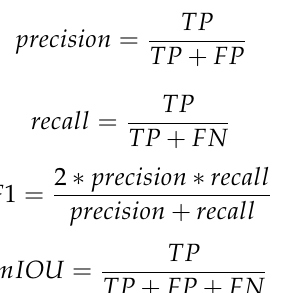
Figure 8. Comparison example of model experiment results on the WHU dataset. ( a ) Image T1, ( b ) Image T2, ( c ) truth map of change detection, ( d ) the result of FC-Siam-diff, ( e ) the result of Unet++, and ( f ) the result of this paper. The red rectangular boxes and red arrows mark the differences between the variogram (CM) and the true value graph (GT) given by the model.